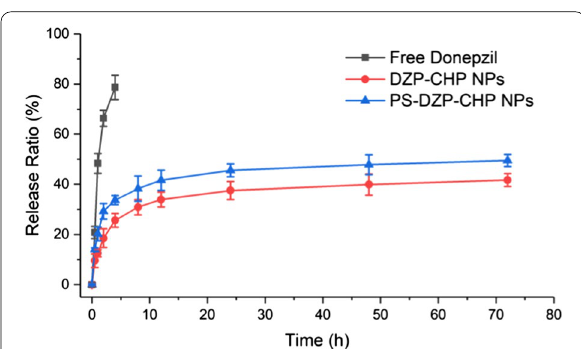
Fig. 4 In vitro drug release curves for DZP, DZP-CHP NPs (1:5) and PS-DZP-CHP